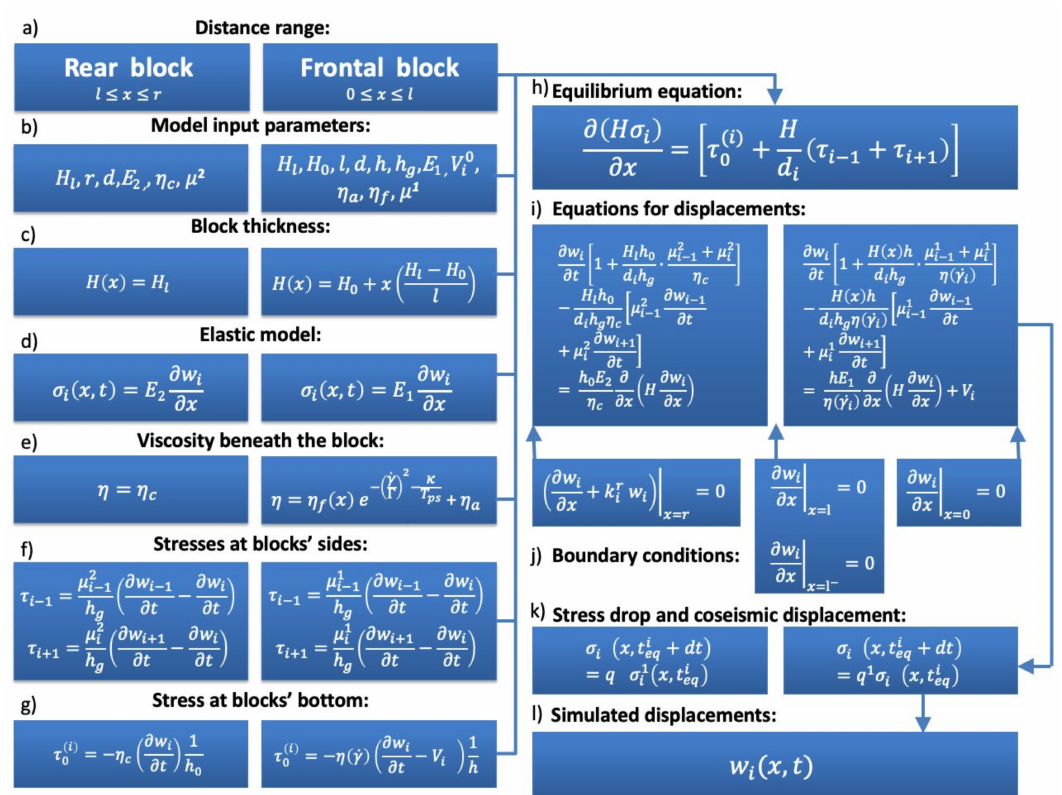
Figure 9. Flowchart showing calculation scheme of the generalized (two-element) keyboard model. ( a ) Schematic repre- sentation of rear (left) and frontal (right) modeling domains (blocks); ( b ) model input parameters for the rear (left) and frontal (right) blocks; ( c ) block thickness; ( d ) 1-D elastic model; ( e ) viscosity as function of x and t : constant viscosity beneath the rear block (left), time-dependent viscosity of the contact layer beneath the frontal block (right); ( f ) stresses acting on lateral sides of the blocks; ( g ) stress acting at the blocks’ bottom; ( h ) stress equilibrium equation; ( i ) equation governing displacement evolution; ( j ) boundary conditions applied at the frontal edge of the frontal block ( x = 0), contact between the frontal and rear blocks ( x = l ), and rear ( x = r ) edge of the rear block; ( k ) stress dumping conditions; ( l ) output